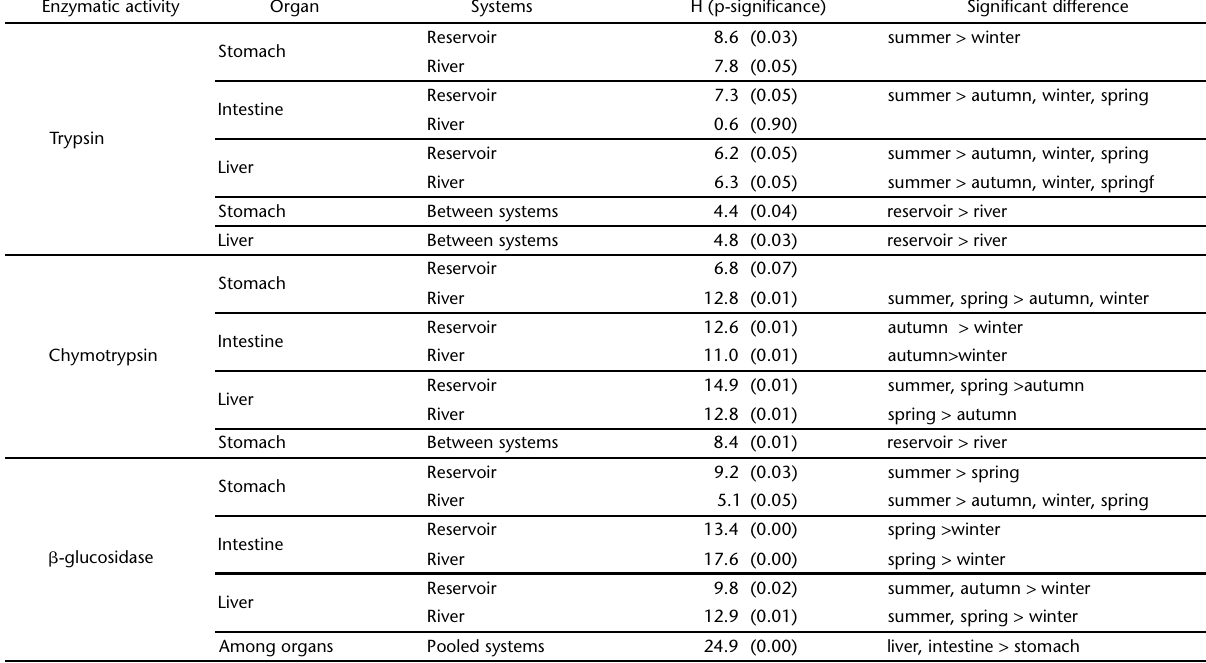
Table III. Significant differences for enzymatic activity of Pimelodus maculatus among seasons and organs for each system, according to non-parametric Kruskal-Wallis test. H and P-significance are shown. Enzymatic